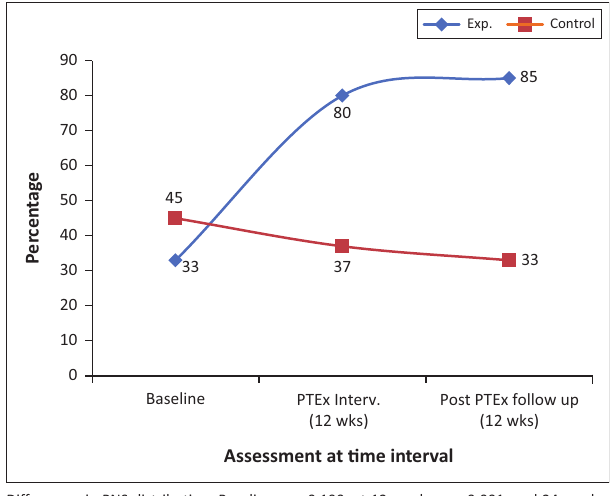
FIGURE 2: The percentage of participants with mild to no peripheral neuropathy symptoms at baseline, 12 and 24 weeks, in the intervention and control groups.